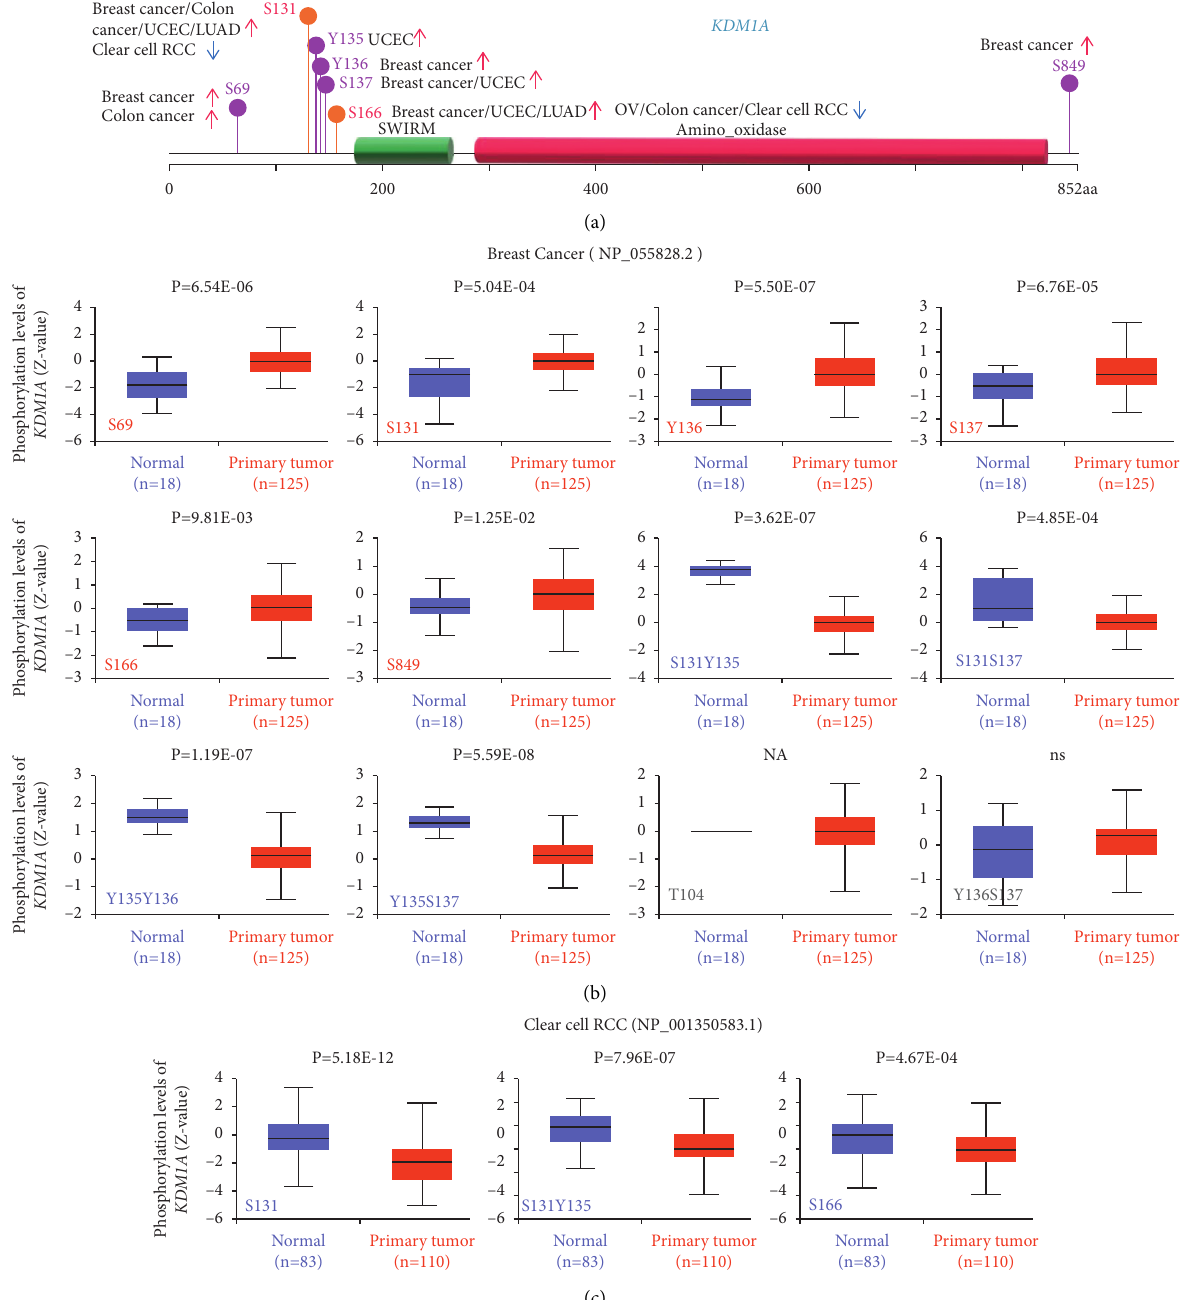
Figure 4: Analysis of phosphorylation levels of KDM1A in different cancers based on the CPTAC data set via the UALCAN. (a) Schematic diagram showed the phosphoprotein sites of KDM1A (NP_001350583.1) that were expressed at different levels in tumors compared with normal tissues. (b) and (c) Phosphorylation analysis of KDM1A protein in breast cancer and clear cell RCC,